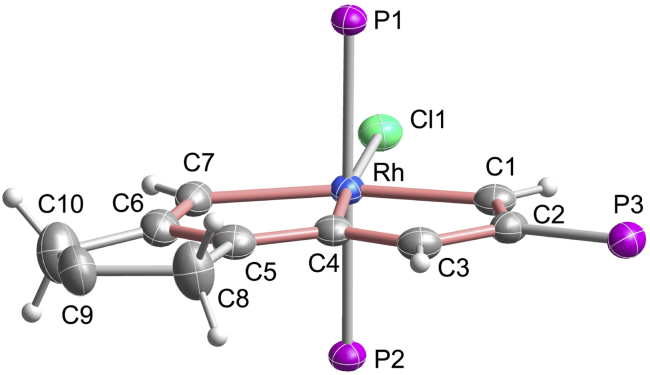
X-Ray Molecular Structure of the Cation of Rhodapentalene 2aEllipsoids are displayed at the 50% probability. The phenyl groups of PPh3 and the ester groups on C9 are omitted for clarity. Selected bond distances (Å) and bond angles (deg): Rh–C1 2.048(3), Rh–C4 1.987(3), Rh–C7 2.056(3), C1–C2 1.372(5), C2–C3 1.425(5), C3–C4 1.362(5), C4–C5 1.405(5), C5–C6 1.387(5), C6–C7 1.399(5); Rh–C1–C2 113.9(3), C1–C2–C3 115.3(3), C2–C3–C4 114.5(3), C3–C4–Rh 116.8(2), C1–Rh–C4 79.39(13), Rh–C4–C5 114.9(2), C4–C5–C6 116.2(3), C5–C6–C7 115.1(3), C6–C7–Rh 113.5(2), C7–Rh–C4 80.14(13).